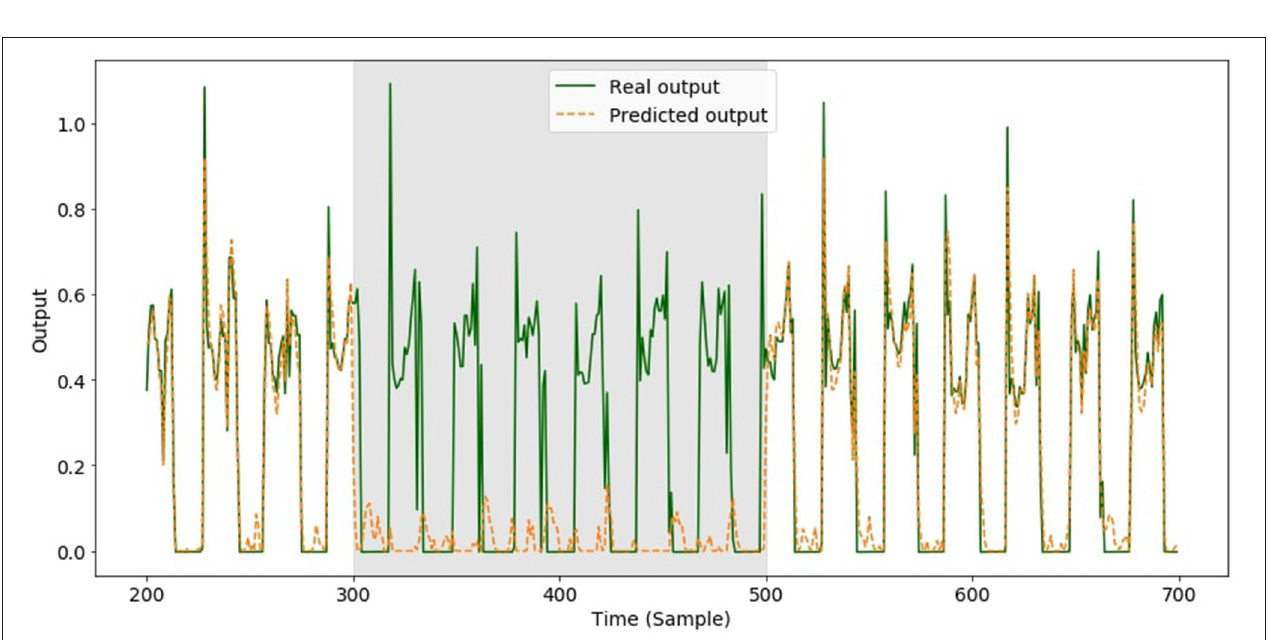
FIGURE 4 | Predicted GRFs of front right leg when the model learnt to predict all GRFs and a fault was introduced over 200 samples (gray area from 300 to 500) in both of the front right leg joints. The training set consisted of data measured using perfectly working sensors.